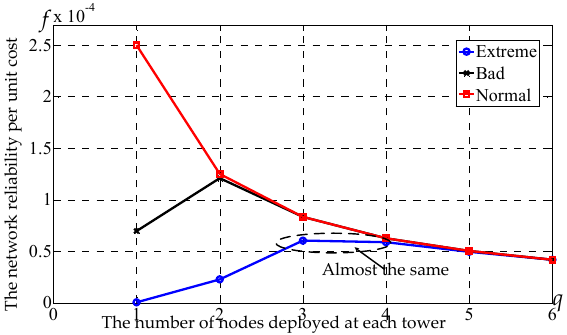
Figure 6. Effect of the number of nodes deployed at each tower.